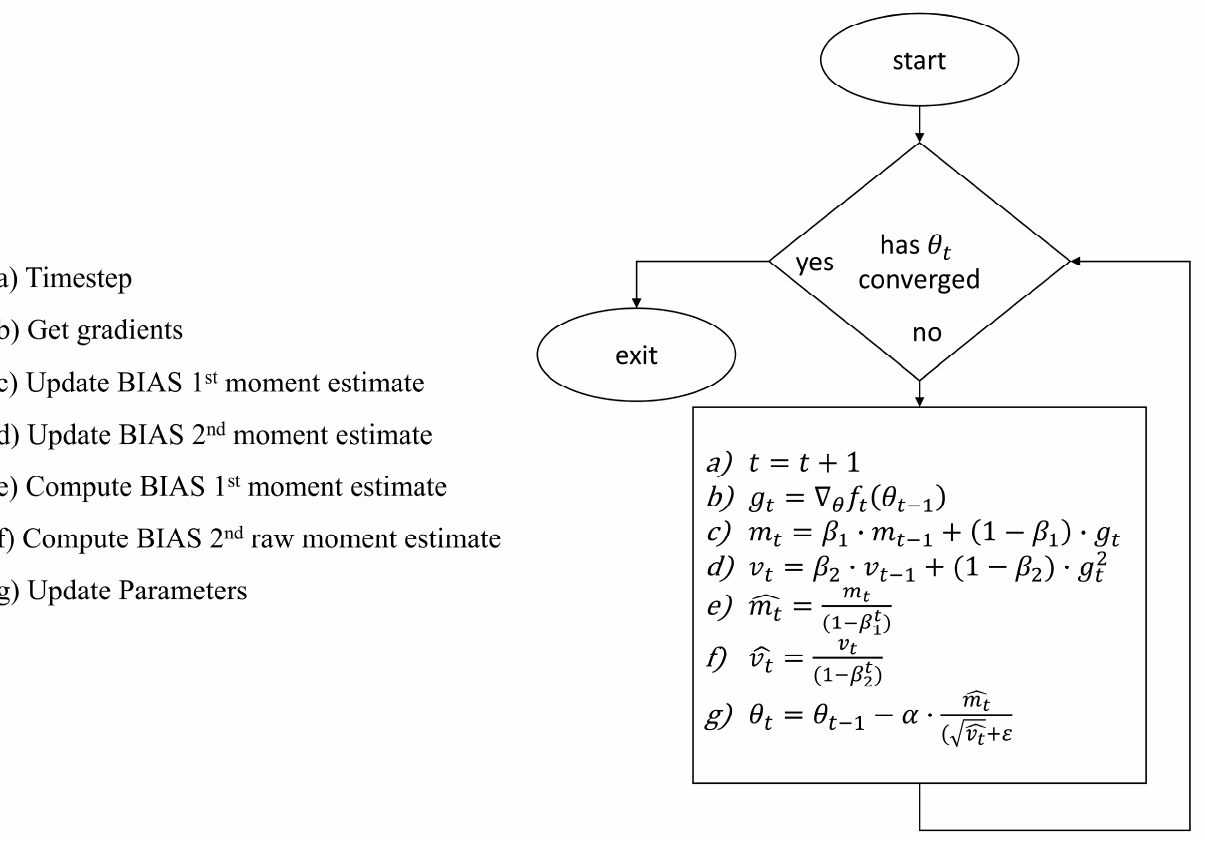
Figure 5. ADAM optimization algorithm workflow.